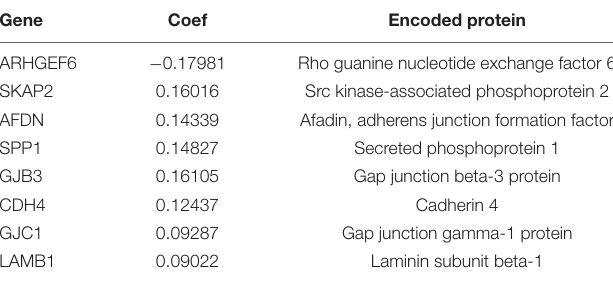
TABLE 2 | The prognostic ICAGs identified by using LASSO COX